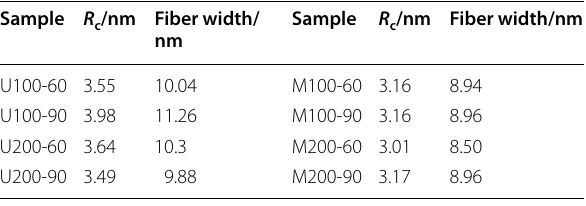
Table 2 Fiber width of samples calculated by cross-sectional Guinier plots